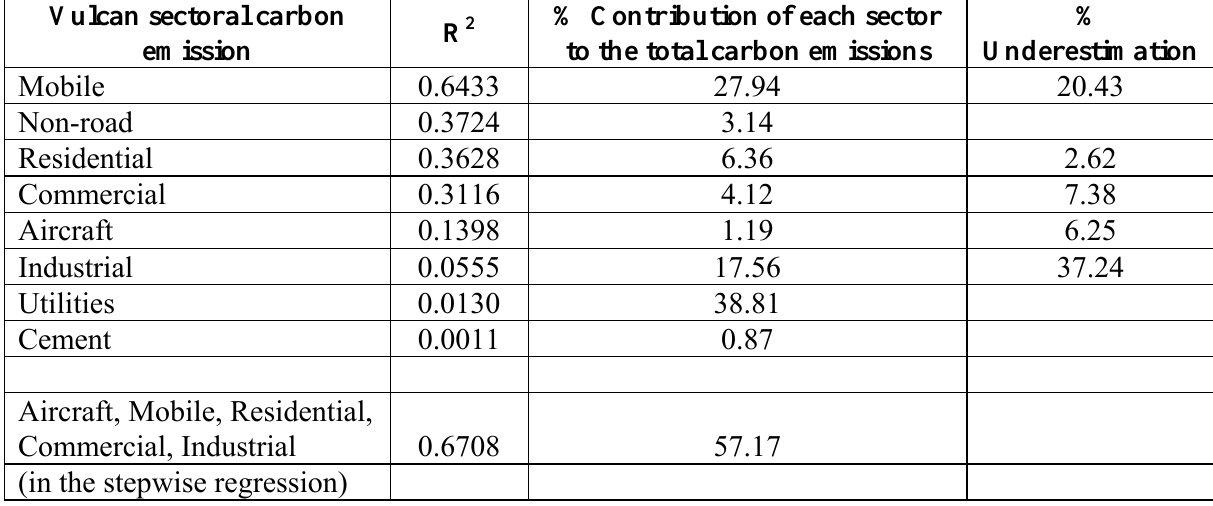
Table 1. Coefficient of determination derived from the stepwise regression, percentage contribution of each sector to the total carbon emissions, and the underestimation percentages of each of the five Model 1 sectors.